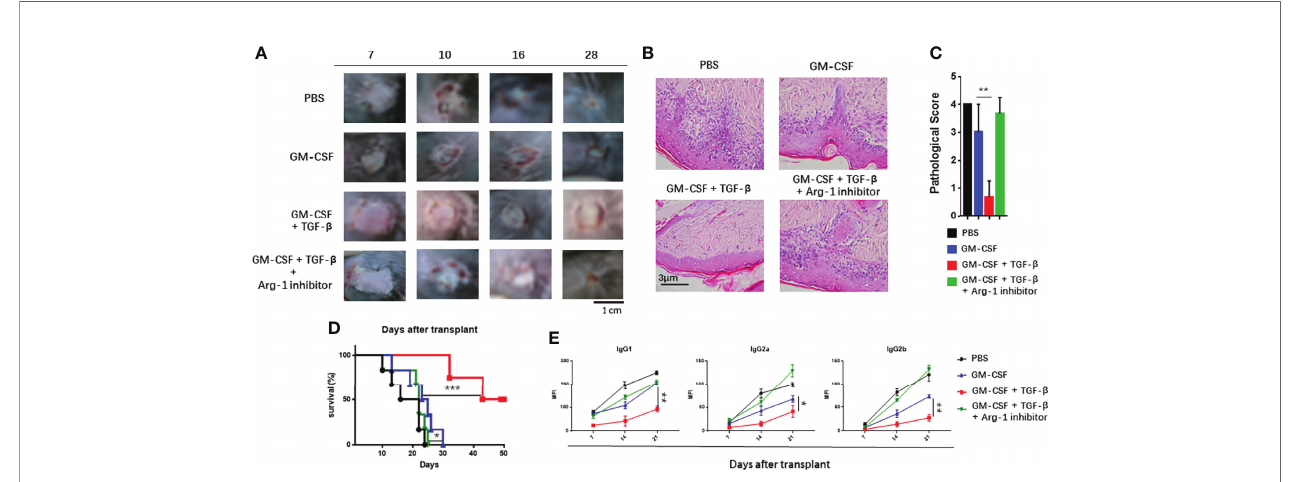
FIGURE 5 | Adoptive transfer of TGF- b + GM-CSF – induced MDSCs could effectively prolong the survival of allo-skin. The recipient female B6 mice were injected intravenously (i.v.) with induced MDSCs (5 × 10 6 ) on day 1 before operation and day 7 after operation. The mice in the control group were injected i.v. with vehicle PBS. In addition, TGF- b + GM-CSF – induced MDSCs and Arg-1 inhibitor, nor-NOHA, was administered to another group. (A) The photographs of the graft rejection have been shown in the four different groups. (B) Representative HE staining of skin grafts on day 21 has been shown (400×). (C) Quanti fi cation of H&E staining corresponding to the four groups on day 21. (D) The survival time of the graft after transplantation have been summarized (n = 6). P values were determined by log- rank tests. * P < 0.05, ** P < 0.01, and *** P < 0.001 compared between the different groups. (E) The levels of the donor-speci fi c antibodies (DSAs), IgG1, IgG2a, and IgG2b were detected by FCM analysis. The data have been shown as mean ± SEM (n = 3) and were analyzed by one-way ANOVA analysis. * P < 0.05, ** P < 0.01, and *** P < 0.001 compared between the different